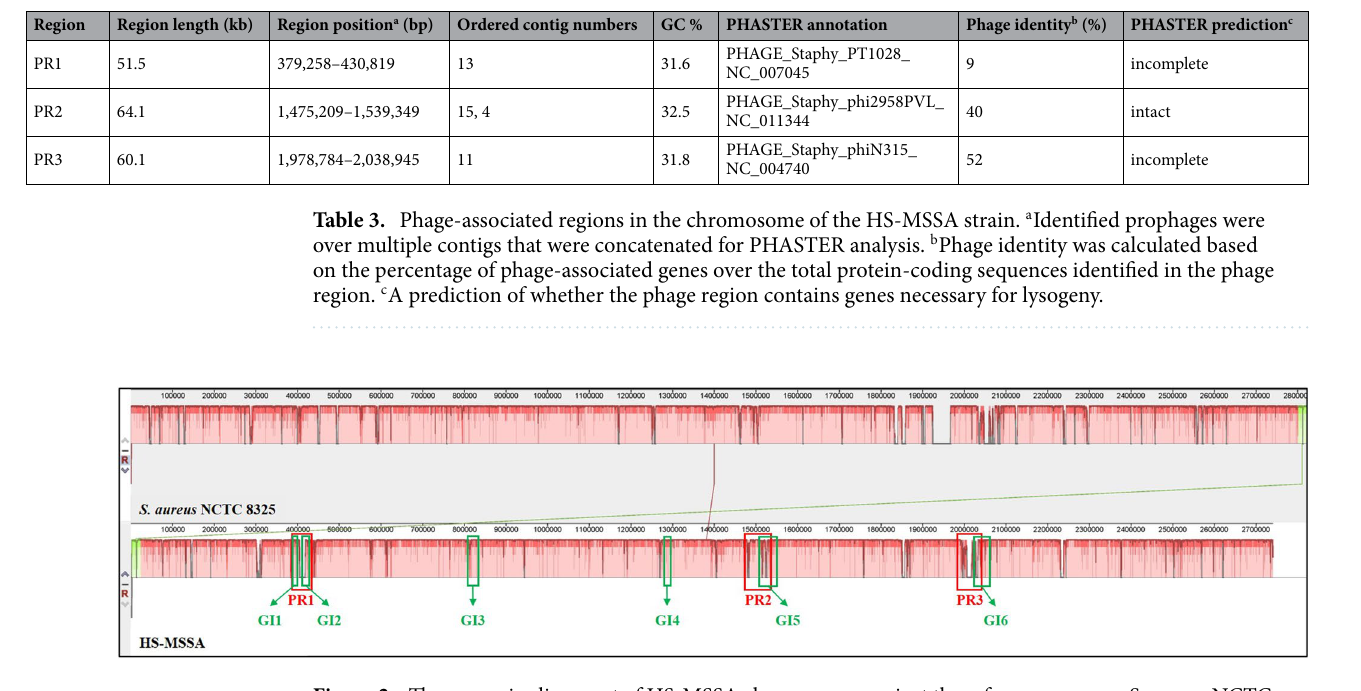
Figure 2. The genomic alignment of HS-MSSA chromosome against the reference genome S. aureus NCTC 8325. The similarity plot was generated using Mauve version 2.4.0 21 . Genomic regions with a low percentage of similarity are seen as gaps in the similarity plot of the respective genomes. The relative positions of the phage- associated regions (denoted as PR1 to PR3) and the genomic islands (denoted as GI1 to GI6) on the HS-MSSA chromosome are highlighted in red and green boxes respectively.